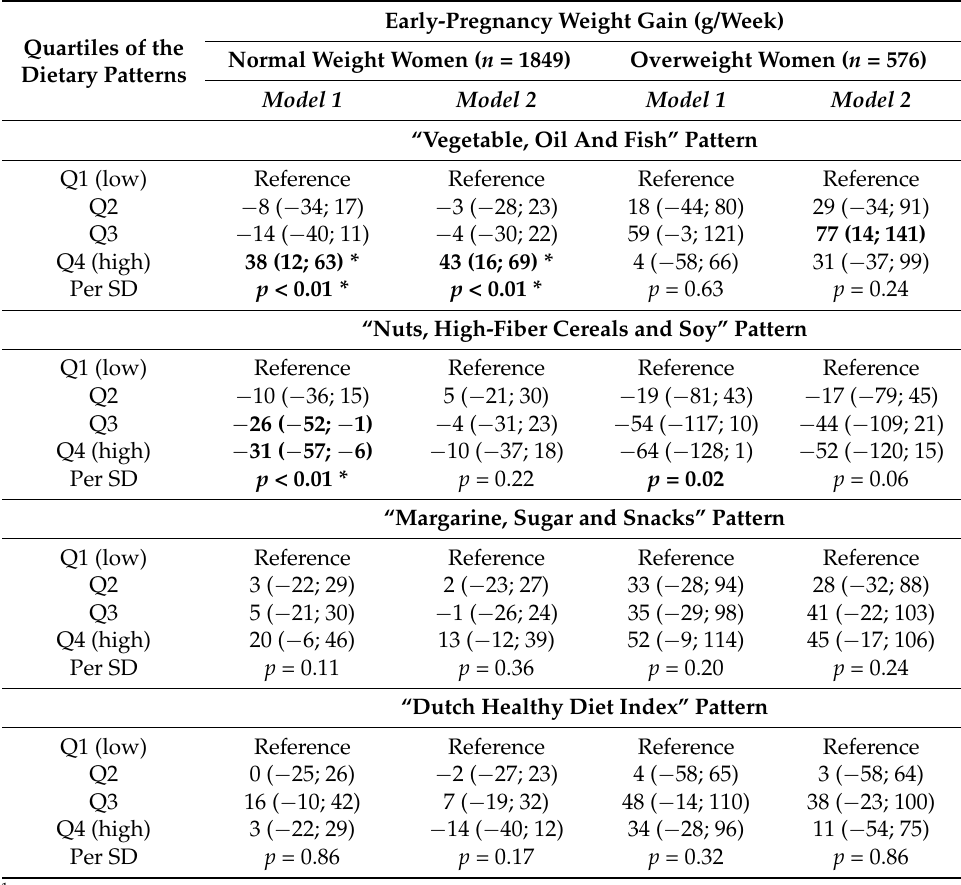
Table 3. Association of dietary patterns with gestational weight gain in early pregnancy ( n = 2425) 1